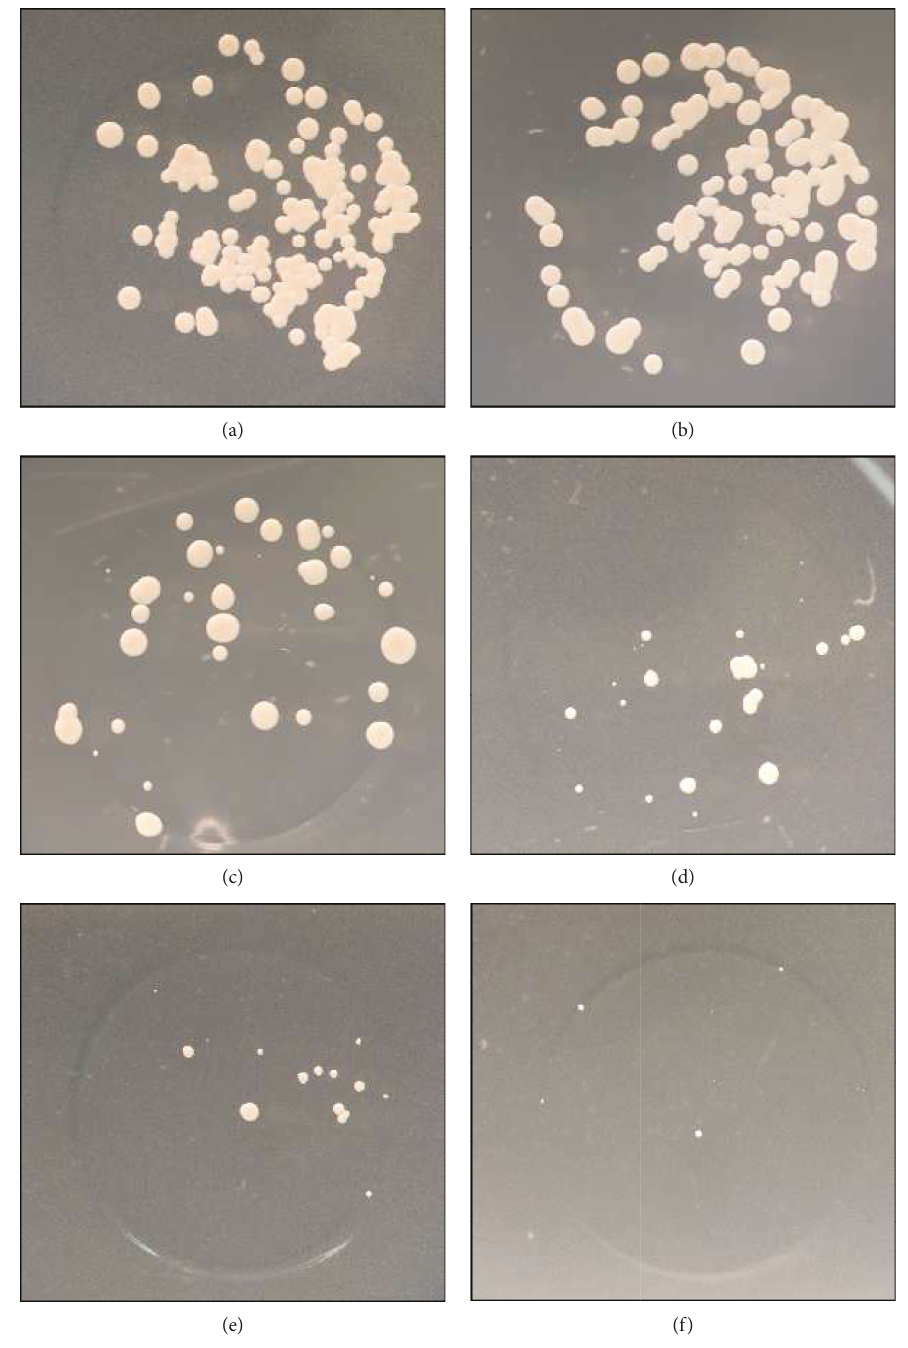
Figure 5: Photographs of tryptic soy agar plates in the stamp assay. The e ff ects of irradiation with a 405nm blue-violet laser on bacteria adhered to the surface of Ti (a, c, e) and HA-PLLA (b, d, f) were analyzed by counting the numbers of colonies formed on tryptic soy agar plates. Compared with the nonirradiated control plates (a, b), colony formation was inhibited by the irradiation for 180s (c, d) and 300s (e, f) in both